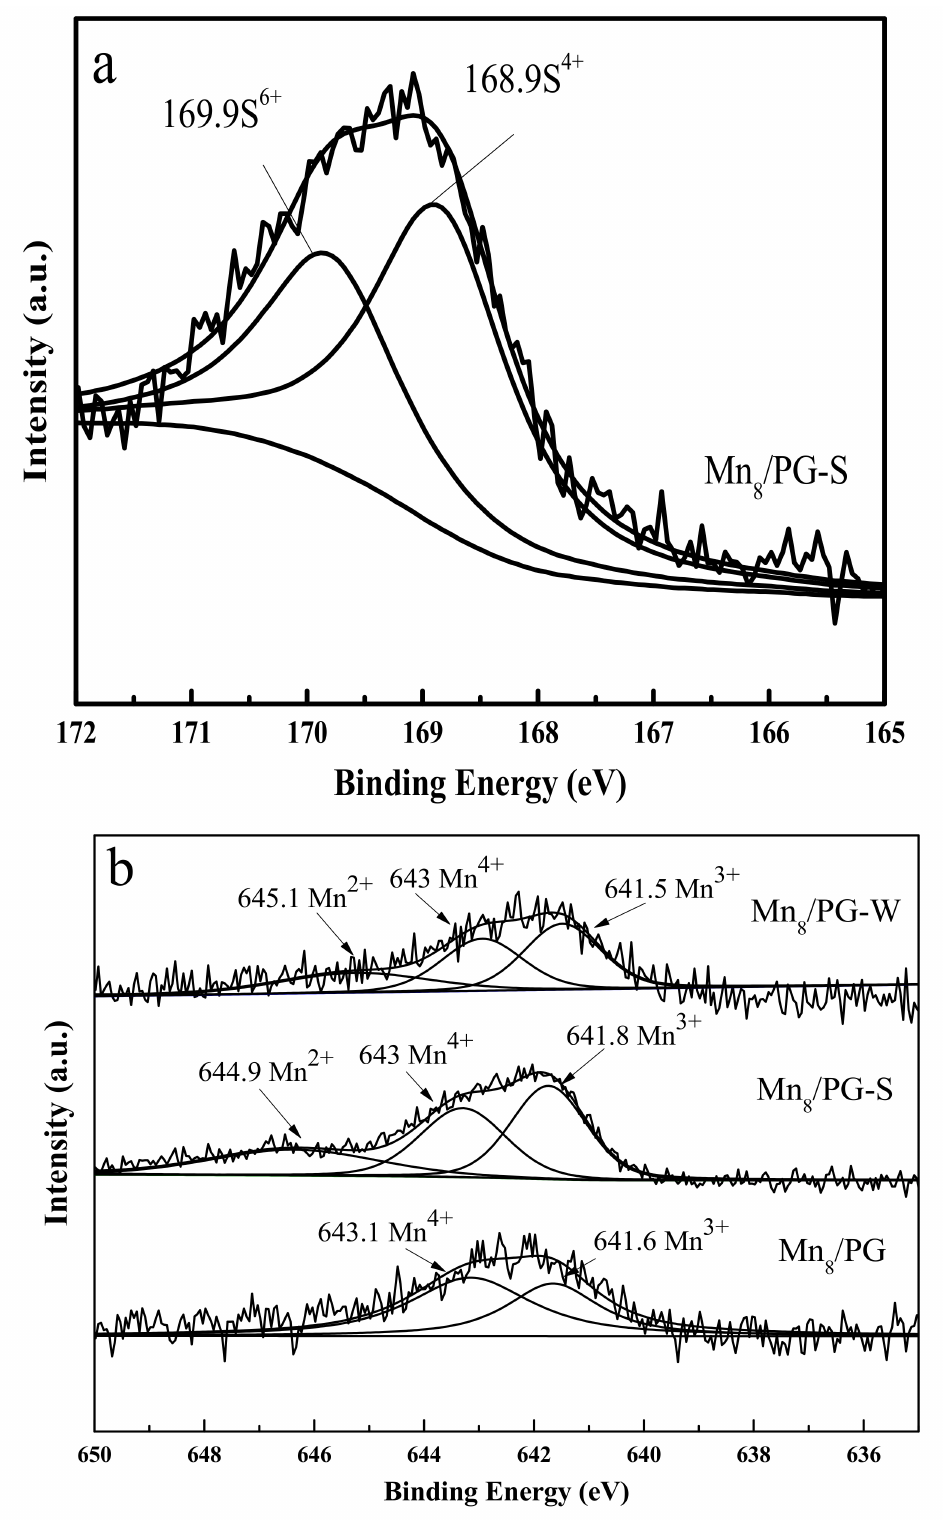
Figure 5. S 2p ( a ) and Mn 2p ( b ) XPS spectra of two different catalysts. The XPS spectra of the Mn 2p orbitals for the three catalysts are shown in Figure 5b. The Mn 2p 3/2 peak of the Mn 8 /PG catalyst can be divided into two peaks: MnO 2 (643.1 eV) and Mn 2 O 3 (641.6 eV) [25]. Based on the calculation of the peak area, the proportions of MnO 2 and Mn 2 O 3 are 68.2% and 38.8%, respectively. The peak of Mn 2p3/2 can be